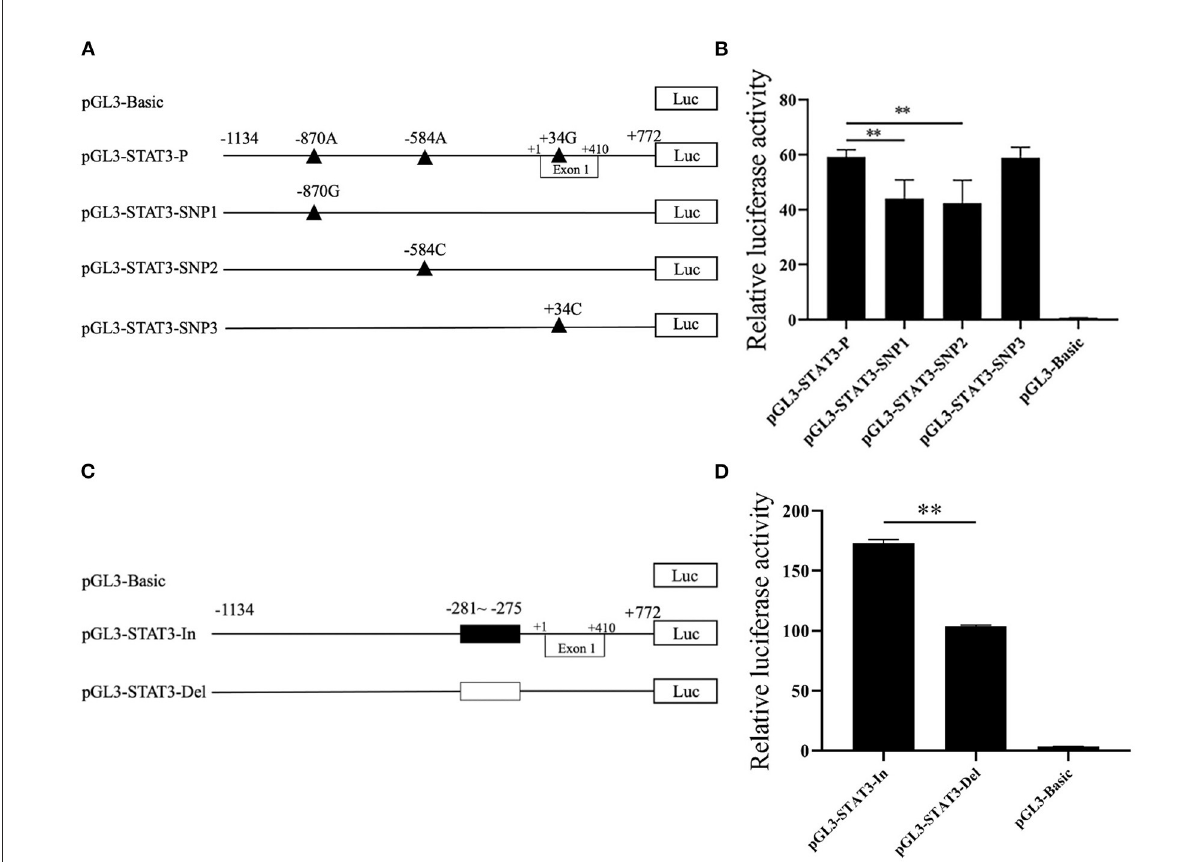
FIGURE3 The effects of candidate genetic variations on porcine STAT3 transcriptional activity. (A) Schematic presentation of luciferase reporter construct for SNP1, SNP2, and SNP3. Genomic fragments carrying the SNPs were inserted the upstream of the SV40 promoter of the pGL3 vector. SNPs were named and numbered from the first nucleotide of the first Exon of porcine STAT3 (ENSSSCT00000018944.5) which was assumed as the putative transcriptional initial site and assigned as + 1. (B) Luciferase assays of different SNPs luciferase reporter constructs in IPEC-J2 cells. (C) Schematic presentation of luciferase reporter constructs of the 6-bp Indel. (D) Luciferase assays of the 6-bp Indel in IPEC-J2 cells. Values are shown as the mean ± SD ( n = 3). ** P <